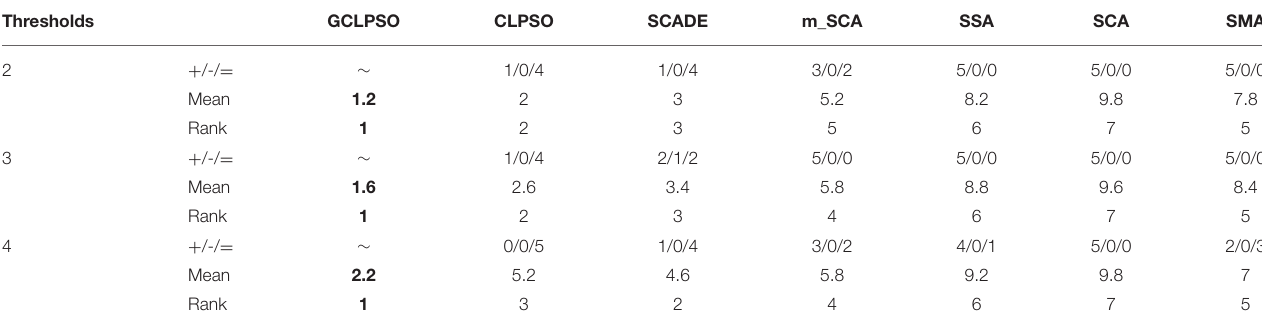
TABLE 2 | Results of the feature similarity FSIM comparison by the Wilcoxon signed-rank test at each threshold level of maize leaf spot disease. Thresholds